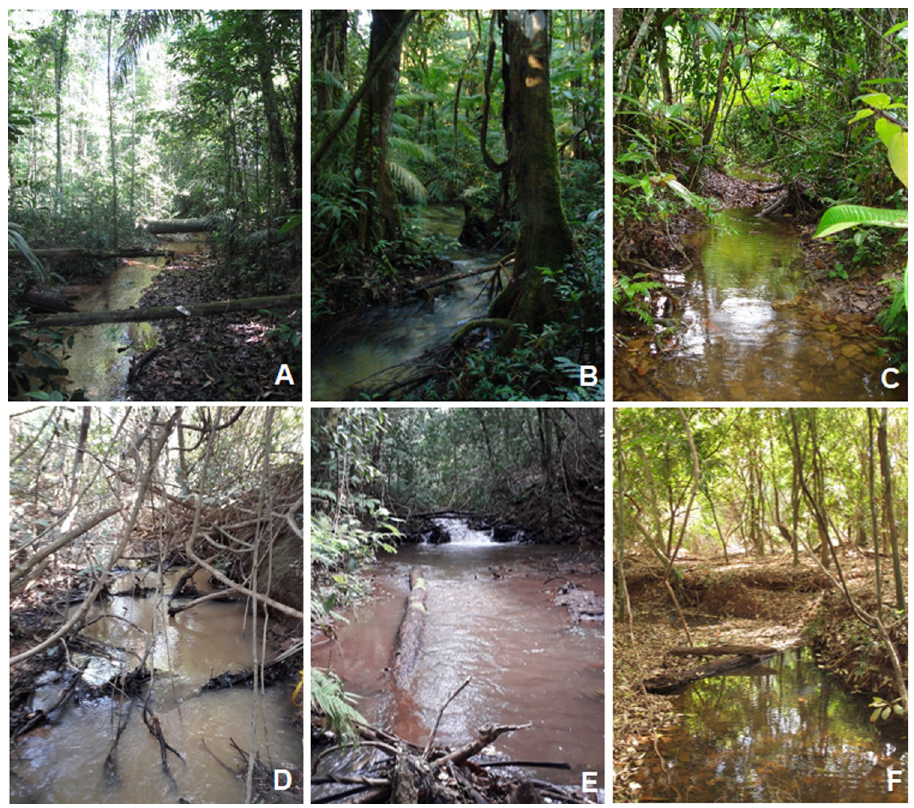
Fig 2. Pictures of typical study streams located in Amazon and Cerrado biomes. One example of each study region is presented. (A) Paragominas- PGM (Amazon), (B) Santare´m—STM (Amazon), (C) Nova Ponte—NP (Cerrado), (D) Tr ê s Marias—TM (Cerrado), (E) Volta Grande- VG (Cerrado) and (F) S ã o Sim ã o- SS